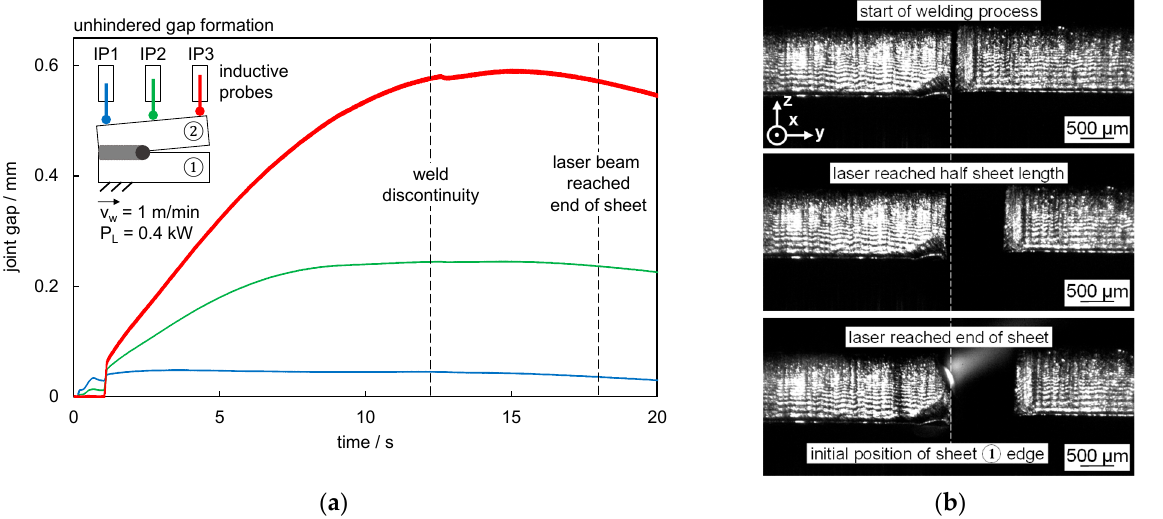
Figure 8. Unhindered gap formation (v w = 1 m/min, P L = 0.4 kW): ( a ) Gap measurement via inductive probes; ( b ) High-speed recording of sheet edges at the end of the specimen at different times.